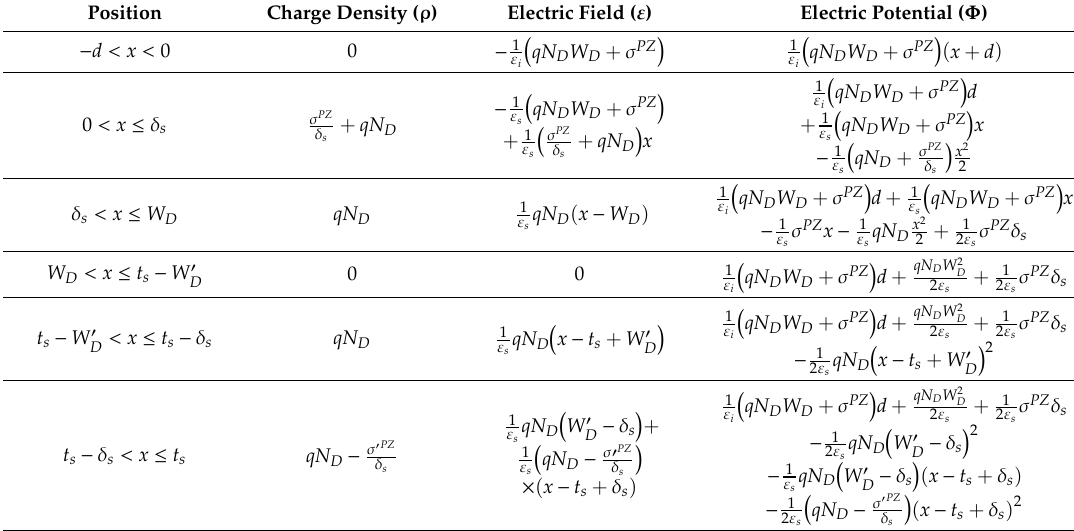
Table 3. Charge density, electric field, and potential of the metal–insulator–semiconductor (MIS) structure with finite semiconductor thickness and piezoelectric charges. Position Charge Density ( ρ ) Electric Field ( ε